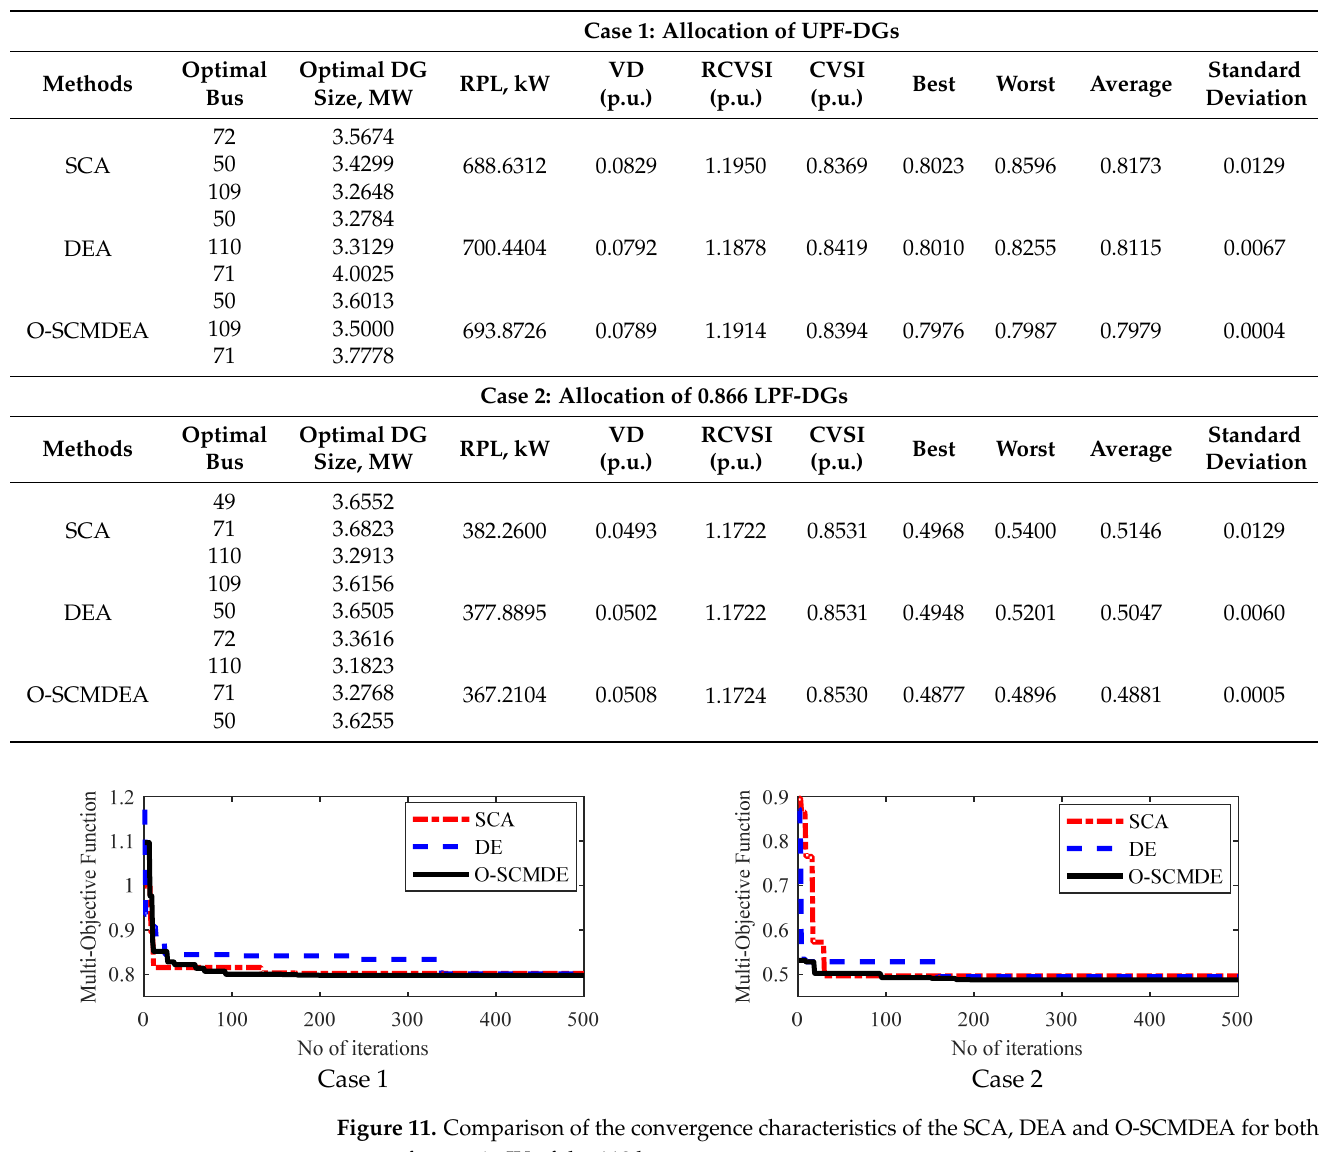
Figure 12. Voltage profile of the 118 bus test system for scenario IV. Figure 13. Branch current profile of the 118 bus test system for scenario IV. 5.3. Test System 3 (136 Bus) Test system 3 is a 136 bus [48] large-scale distribution network that caters to total real and reactive power loads of 18,314 kW and 7932.5 kVAr, respectively. A voltage and power base of 13.8 kV and 100 MVA are chosen for the test system.